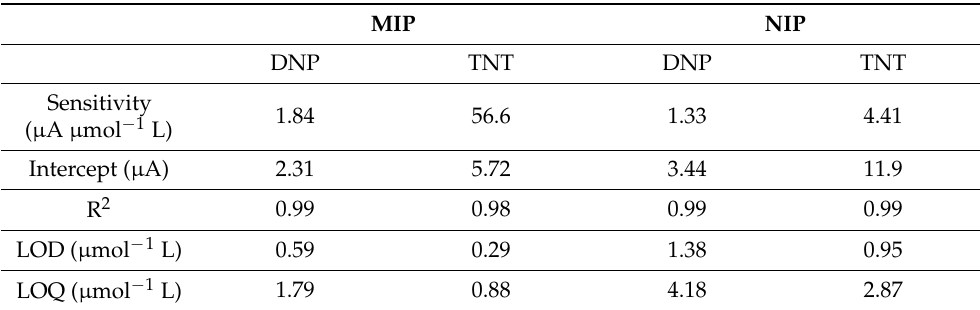
Table 2. Summary of calibration results in the linear concentration region from 1.6 to 8.0 µ mol L − 1 towards DNP and from 1.3 to 6.5 µ mol L − 1 for TNT. MIP NIP DNP TNT DNP TNT